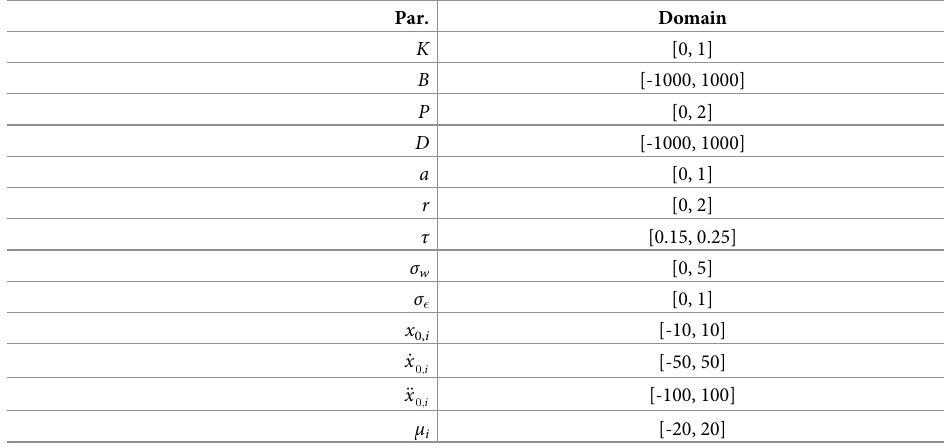
Table 2. Optimization bounds for all parameters.